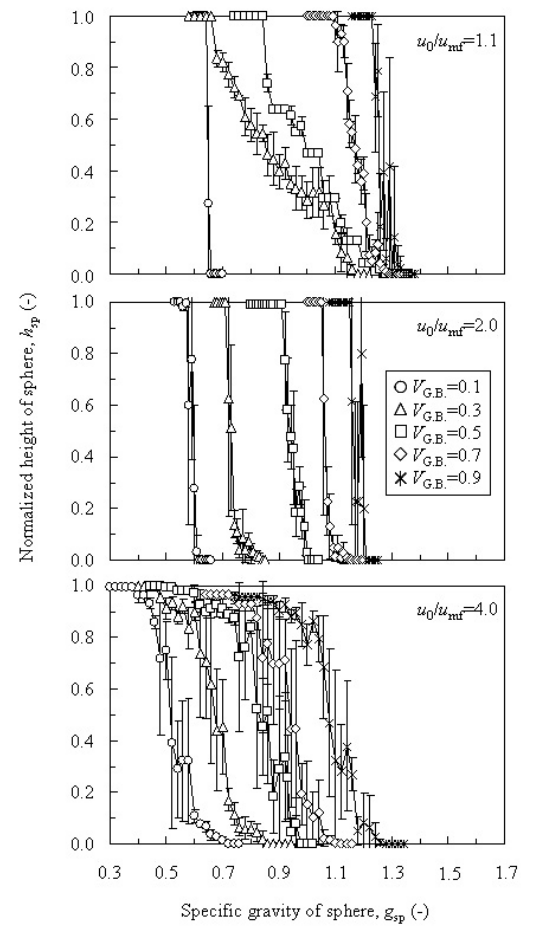
Fig.1 Dependences of normalized height on specific gravity of sphere for various bulk volume fractions of